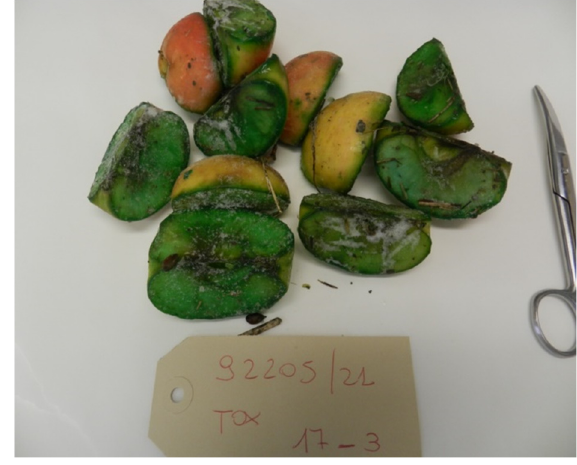
Figure 7. Typically deep green apples.